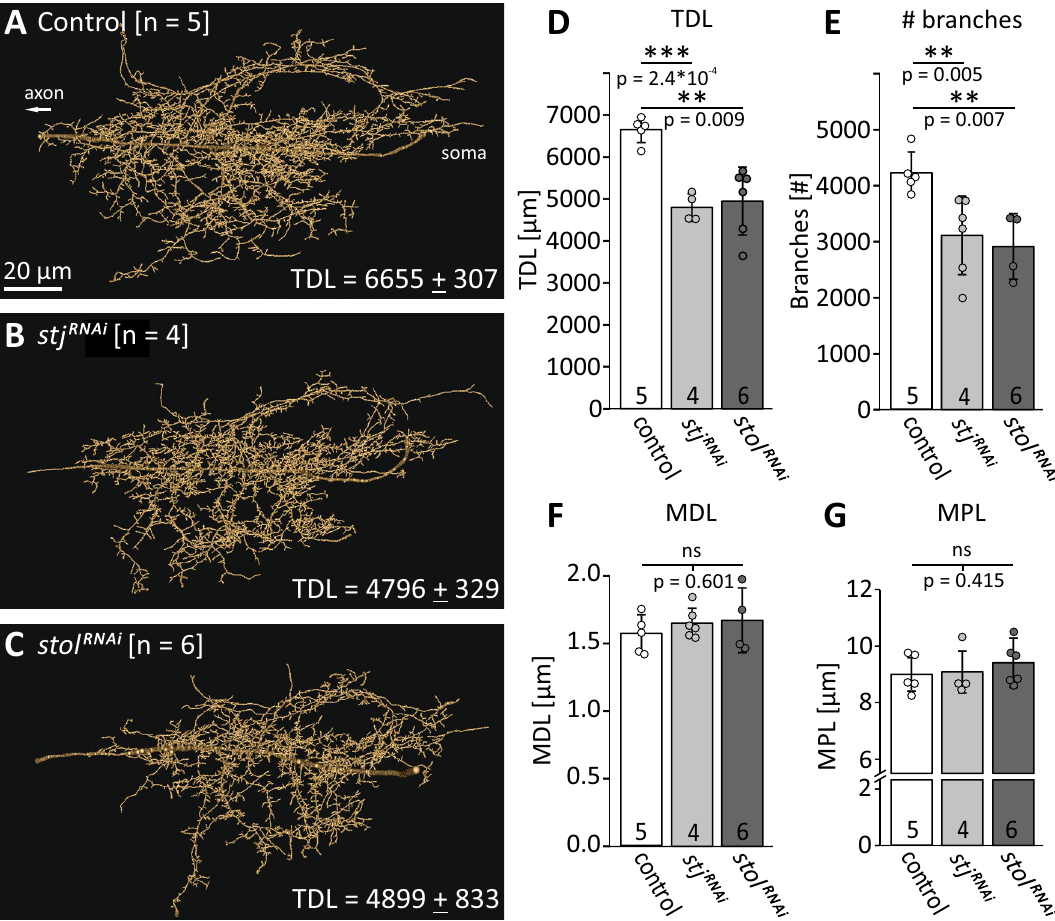
Figure 5. stj and stol affect dendrite development. (A – C) Reconstructions of adult MN5 dendrite in control ( A , n = 5) and following stj RNAi ( B , n = 4) and stol RNAi ( C , n = 6). (D – G) Morphometric parameters were analyzed. Following stj RNAi as well as stol RNAi total dendritic length ( D , TDL, control: 6,655 ± 307 µm vs. stj RNAi : 4,796 ± 329 µm, *** p = 2.37*10 −4 and control vs. stol RNAi 4,899 ± 833 µm, ** p = 0.009; one-way ANOVA with Games–Howell post hoc test) as well as the number of dendritic branches ( E , # branches, control: 4,241 ± 375 µm vs. stj RNAi : 2,914 ± 586 µm, ** p = 0.005 and control vs. stol RNAi : 3,122 ± 700 µm, ** p = 0.007, one- way ANOVA with LSD post hoc test) are significantly reduced. Other parameters like mean dendrite length ( F , MDL, control: 1.57 ± 0.14 µm vs. stj RNAi : 1.7 ± 0.2 µm, and control vs. stol RNAi : 1.67 ± 0.11 µm; one-way ANOVA, p = 0.601) and mean path length ( G , MPL, control: 9.02 ± 0.6 µm vs. stj RNAi : 9.09 ± 0.87 µm, and control vs. stol RNAi : 9.41 ± 0.74 µm; Kruskal Wallis ANOVA, p = 0.415) are not